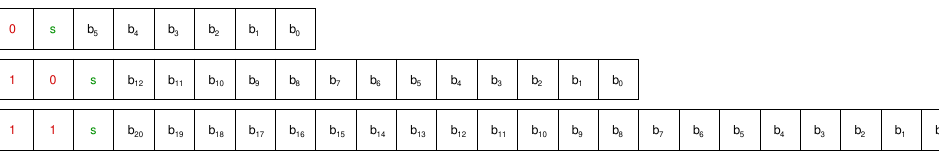
Figure 5. The simple VLDE scheme devised to efficiently send the differentiated EMG signal. Either 8, 16, or 24 bit words are used to store the difference, depending on how many bits are needed to code it in straight binary. “s” is the sign bit, and the fixed red bits allow the discovery of the used word length. 20 significant bits plus sign is exactly the maximum needed to store differences between 20bit signal samples, so longer words cannot ever be